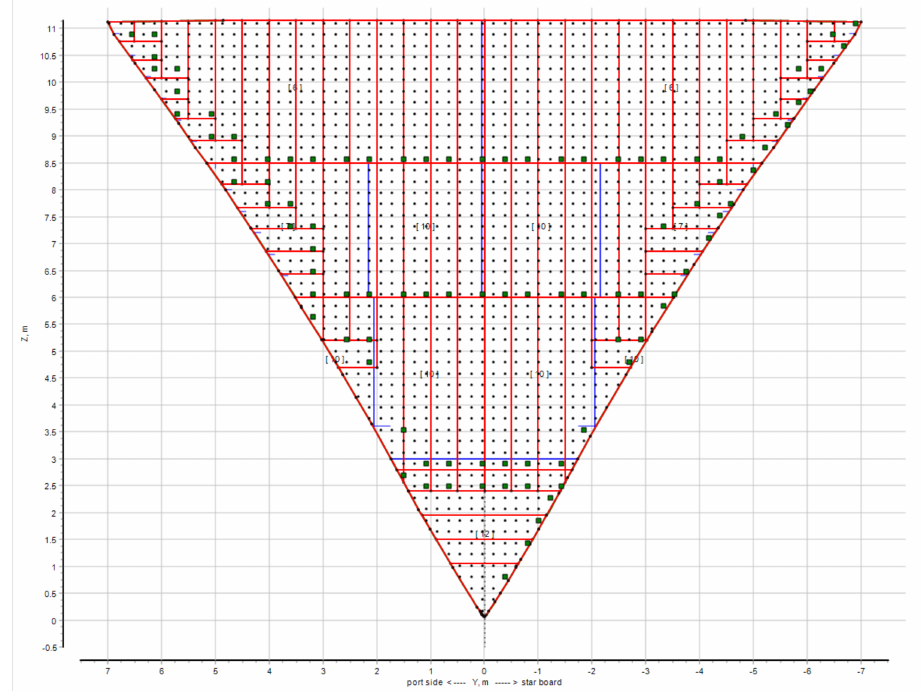
Figure 10. Primary points space for panels searching. Green color boxes shows the points, the creation of which led to the panel detection, gray color shows passes along the already detected loops and these are not taken into account, the red lines are the borders of the EPP, the blue lines are the borders of the plates.